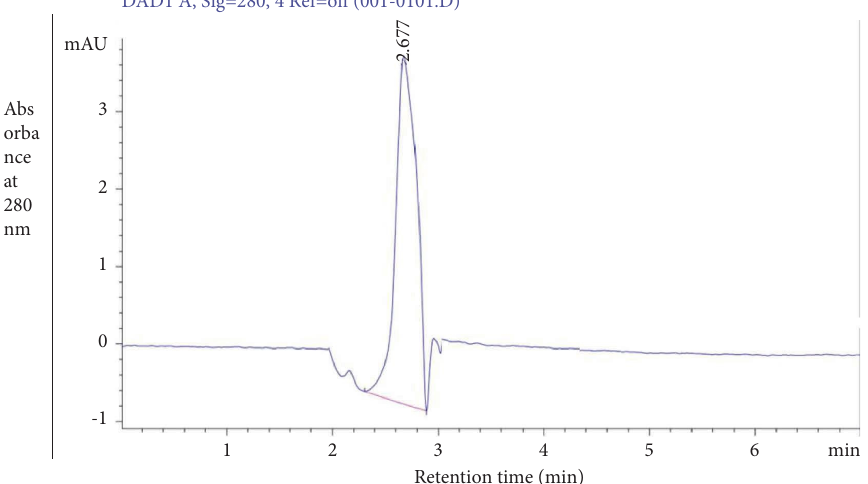
Figure 5: HPLC analysis of Datura stramonium purifed stem protein shows that one peak of retention time is 2.677 at 280 nm.